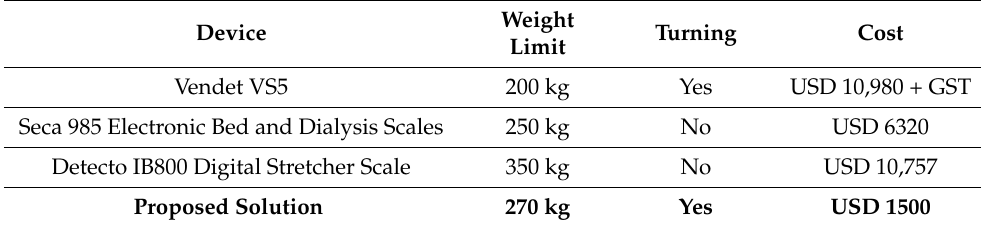
Table 4. Comparison of commercially available